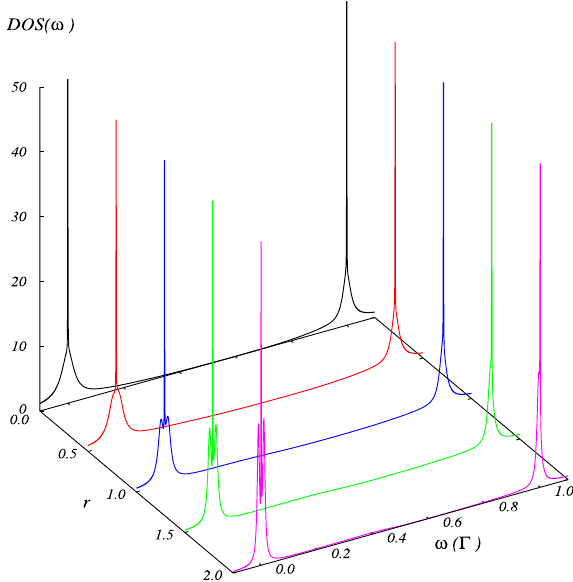
Figure 6. Total DOS in the interacting case, calculated as a function of the energy and r for indicated values of rate of coupling: r parameters: U